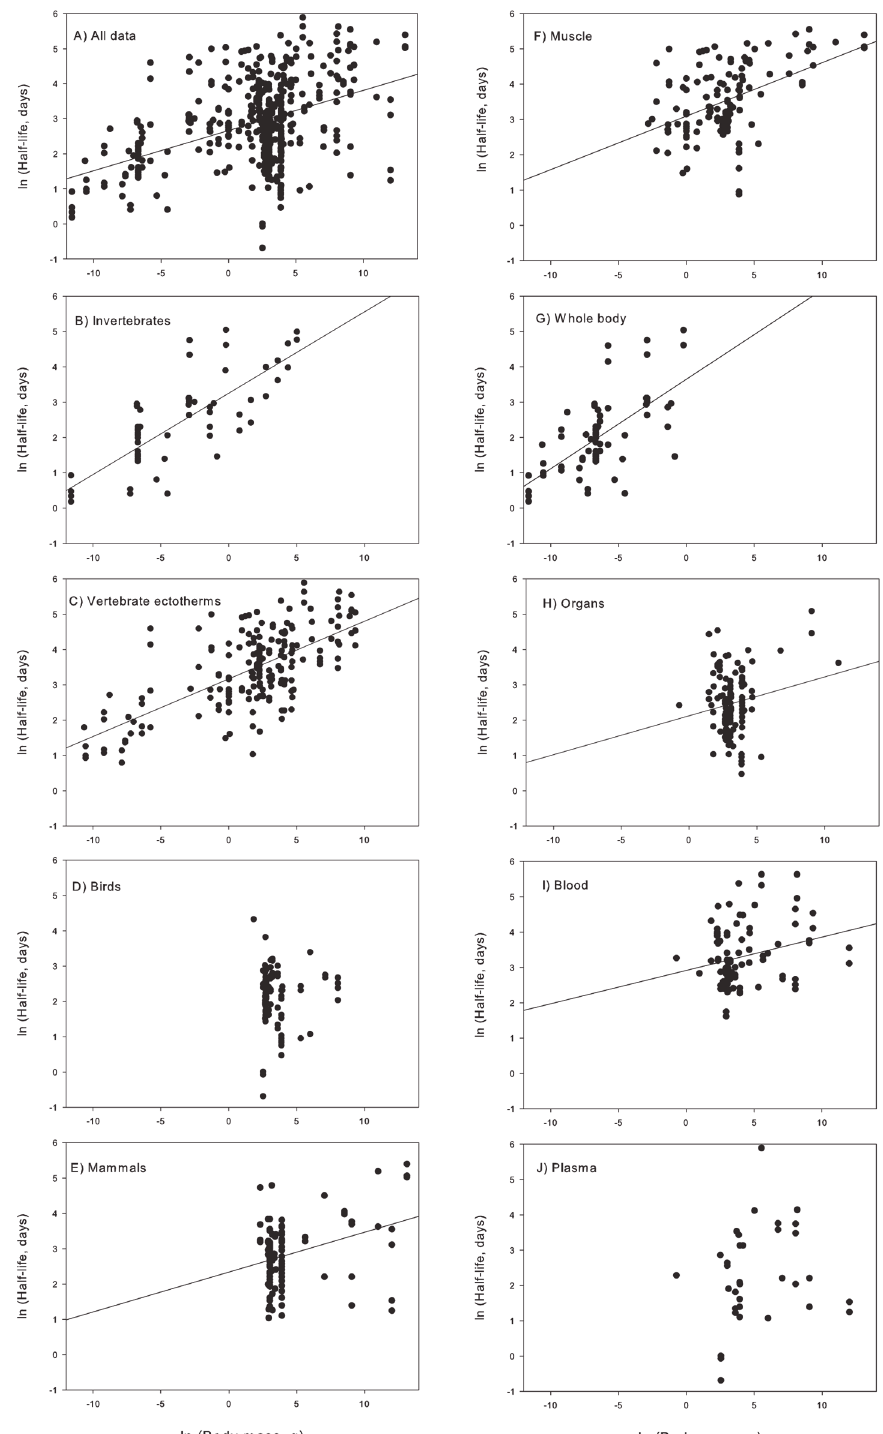
Fig 2. Relationships between ln(animal body mass, grams) and ln(isotopic half-life, days). A) Plot for all tissue types and taxonomic groups combined. B – E) Plotted separately for each taxon. F – J) Plotted separately for each tissue type. Regression information for each tissue type and taxa are presented in Table 1.